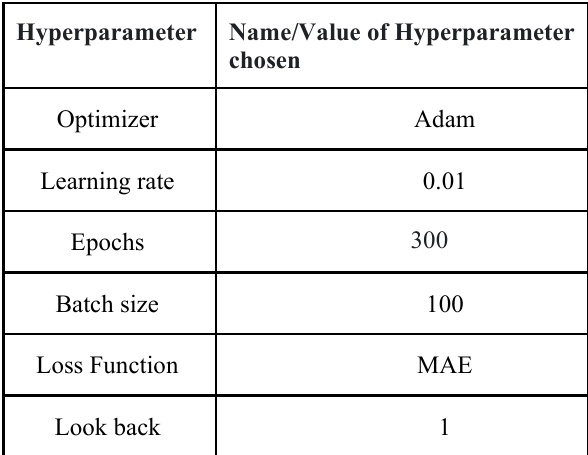
Fig. 7. Comparison of RMSE values whilst using different loss functions, best performing optimizer and epochs value. Table 4. Hyperparameters with their corresponding chosen